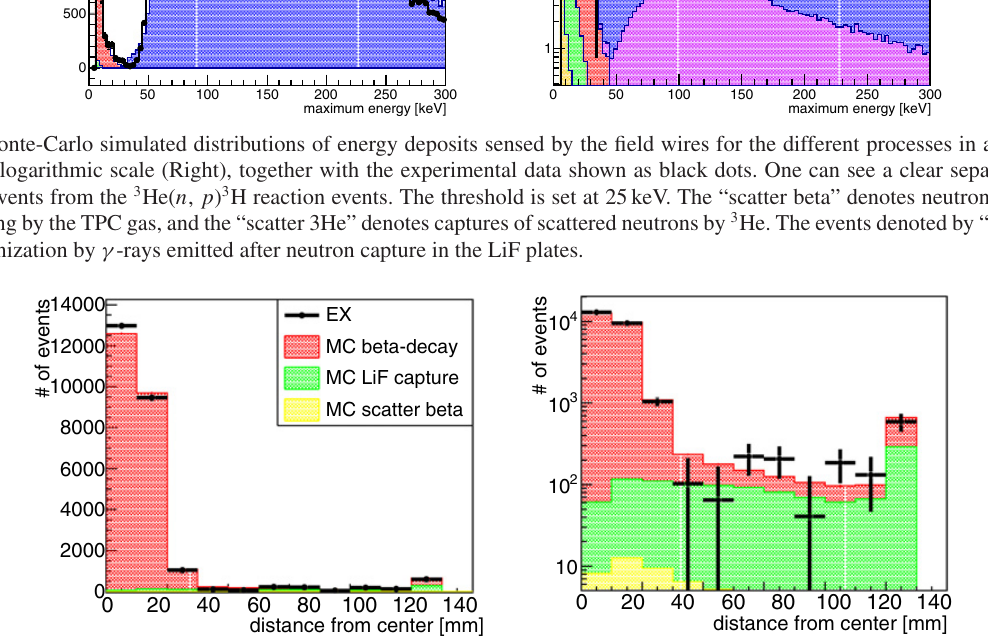
Figure 7. Distribution of the “distance from center” parameter in a linear scale (Left) and a logarithmic scale (Right). The event types shown are the same as in Fig.